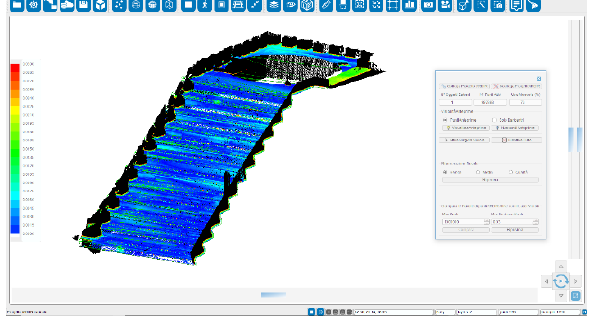
Figure 7. Stair: Advanced 3D model vs TLS points cloud.